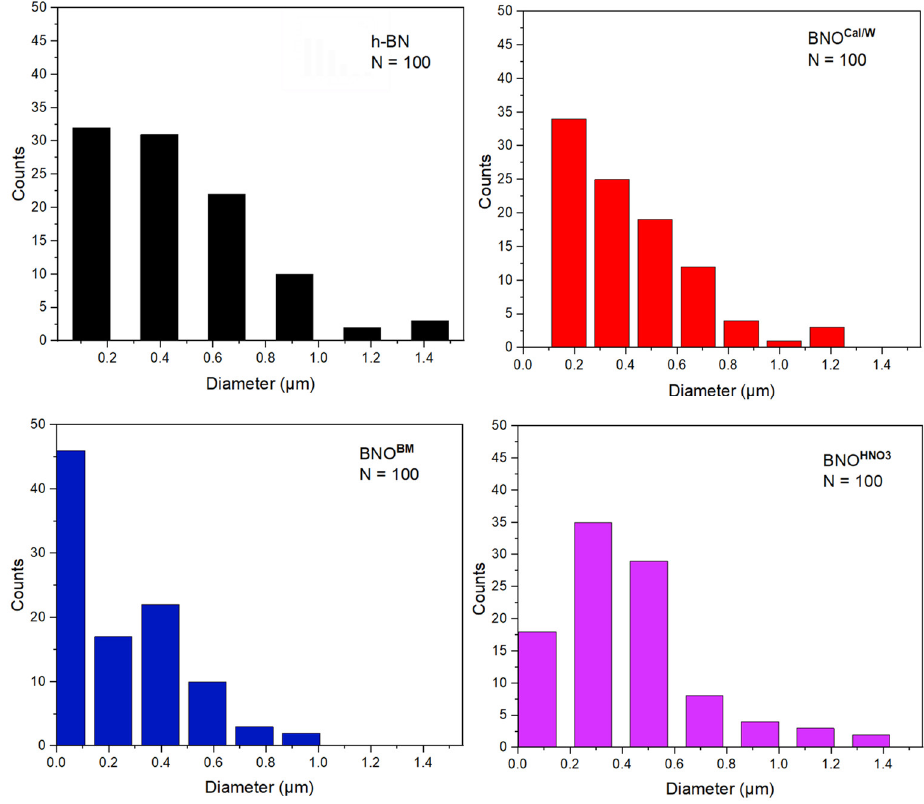
Figure 8. Particle size distribution of h-BN and hydroxylated BNO using ImageJ software (ImageJ; version 1.53s, Software for scientific image processing; US National institute of Health; USA, 2022).